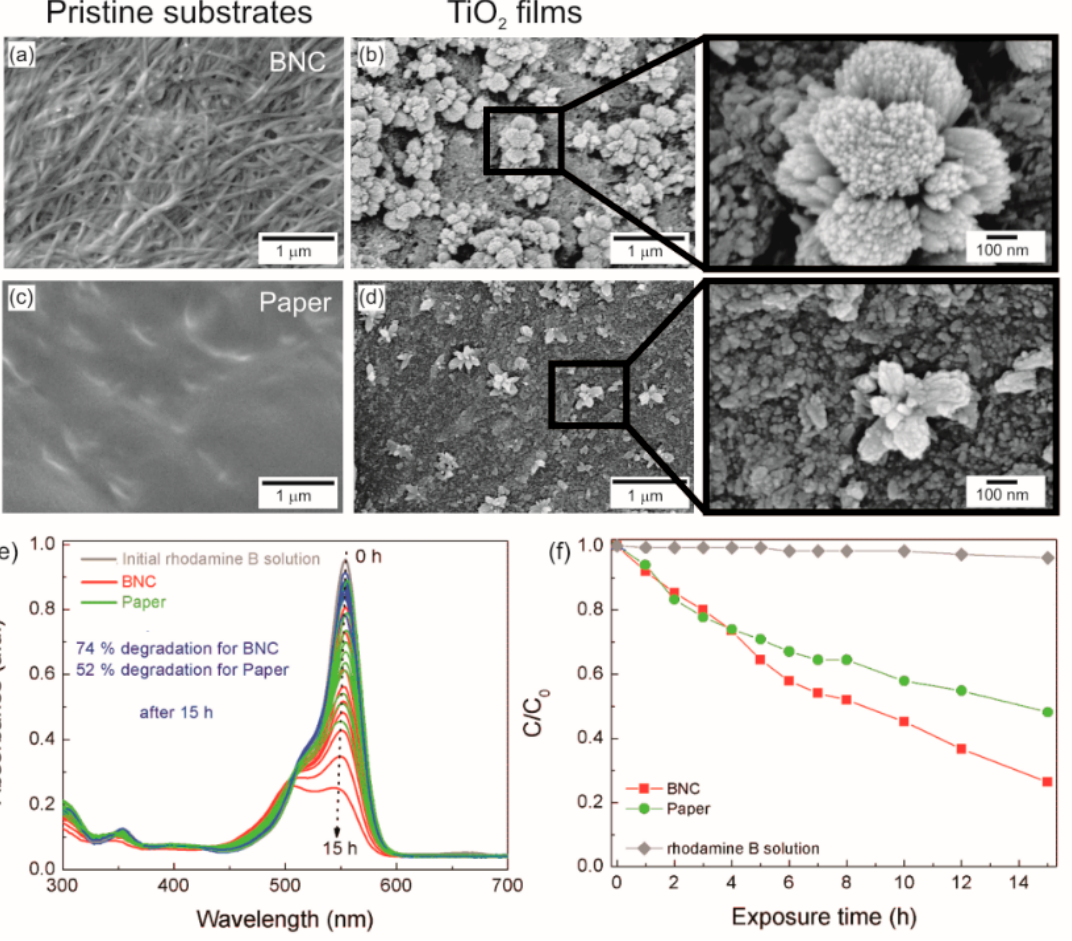
Figure 8. SEM images showing the BNC ( a ) and tracing paper ( c ) pristine substrates together with the TiO 2 films grown on BNC ( b ) and tracing paper ( d ) substrates. The insets show the TiO 2 films and the nanorod flower-like structures. Rhodamine B absorbance spectra at different solar light exposure times up to 15 h ( e ). Rhodamine B degradation ratio (C/C 0 ) vs. solar simulating light exposure time ( f ). Reproduced with permission of Springer Nature [19].